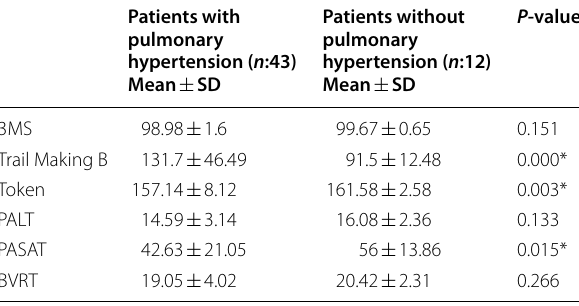
Table 5 Comparison between patients with and without pulmonary hypertension regarding cognitive function